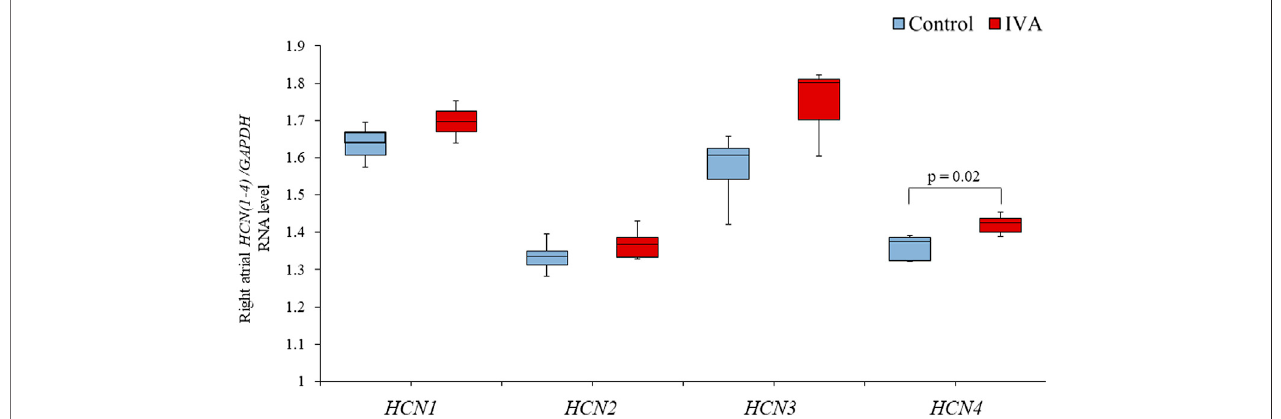
FIGURE 3 | Right atrial RNA expression of genes encoding for hyperpolarization-activated cyclic nucleotide-gated (HCN) channels in the ivabradine-treated (IVA; n (cid:2) 10) and non-treated (Control; n (cid:2) 6) rats. Data are expressed as median and interquartile range (IQR). The ends of the whiskers represent the lowest value within 1.5 IQR of the fi rst quartile and the highest value within 1.5 IQR of the third quartile.